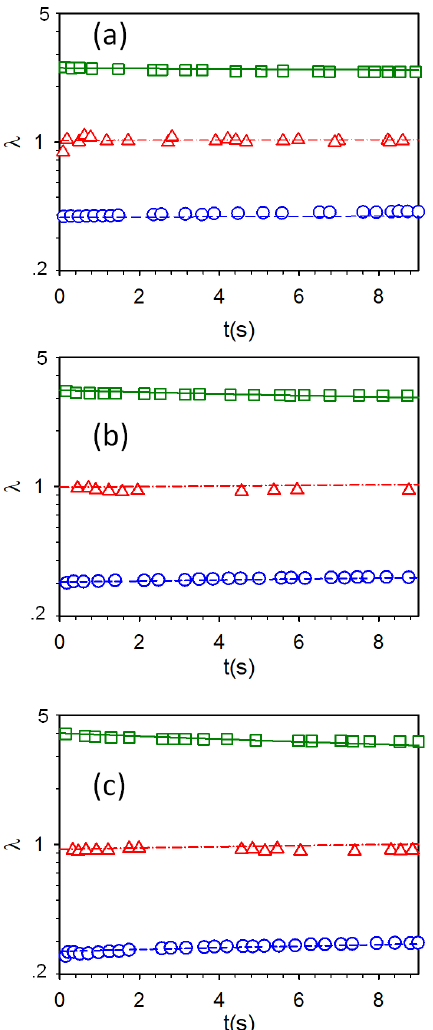
Figure 7: The same experimental data in Figure 6 are compared to the CV-CY model combined with approximate description of rate of deformation inside the droplet during droplet retraction. Parts a, b and c refer to strain value of 4 and shear rate value of 16 s −1 , strain value of 6 and shear rate value of 16 s −1 and strain value of 4 and shear rate value of 24 s −1 ,